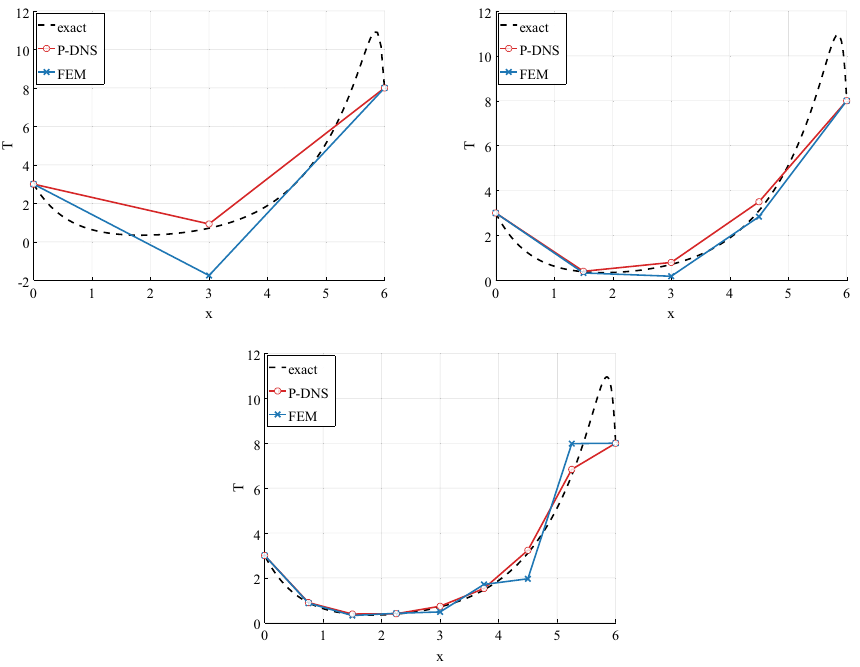
Fig. 9 Advection–diffusion–reaction with an exponential Source with nel = 2 (top-left), 4 (top-right), and 8 (bottom). Nodal results from FEM and P-DNS with np = 2 are compared with the exact solution